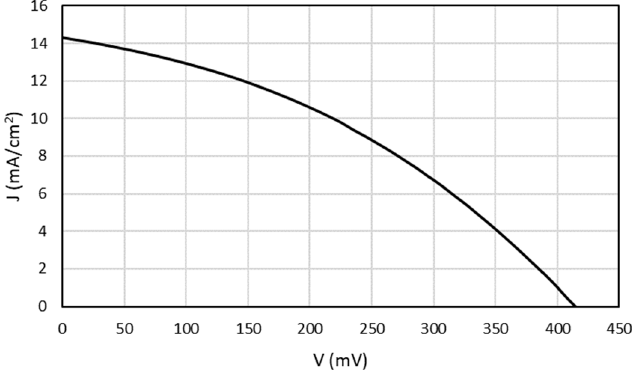
Figure 7. I-V curve of the best SDS solar cell.